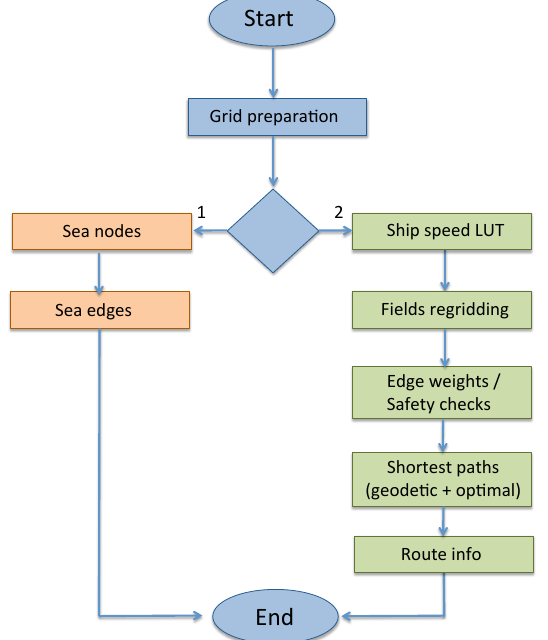
Figure 8. Flow chart of the computer code of VISIR-I model. Func- tioning mode 1 is run just once for preparing graph nodes and edges; mode 2 is the operational one, using sea nodes and edges computed from mode